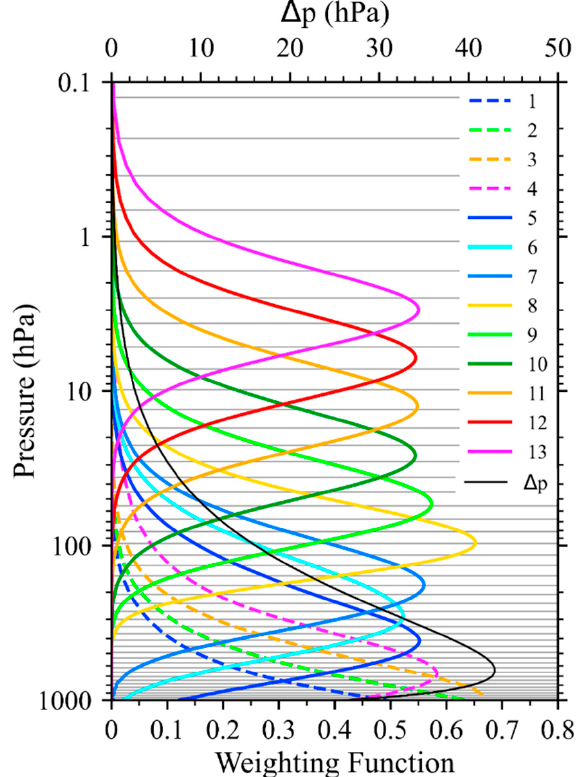
Figure 1. Weighting functions of FY-3D MWTS-2 channels 1–13 (colored curves), calculated by the RTTOV13.0 with the U.S. standard atmosphere profile as input at the nadir. The vertical levels (gray horizontal lines) of RTTOV and the pressure difference between each two neighboring levels of them (black curve) are shown. Table 1. Channel number, central frequency, noise equivalent differential temperature (NEDT), peak weighting function (WF) altitude, and predictor channels of the MWTS-2 channels 1–13. Beam width of each channel is 2.2 ° . Peak WF altitudes are based on the results in Figure 1. Peak WF Channel Channel Frequency (GHz) NEDT (K) Altitude (hPa)